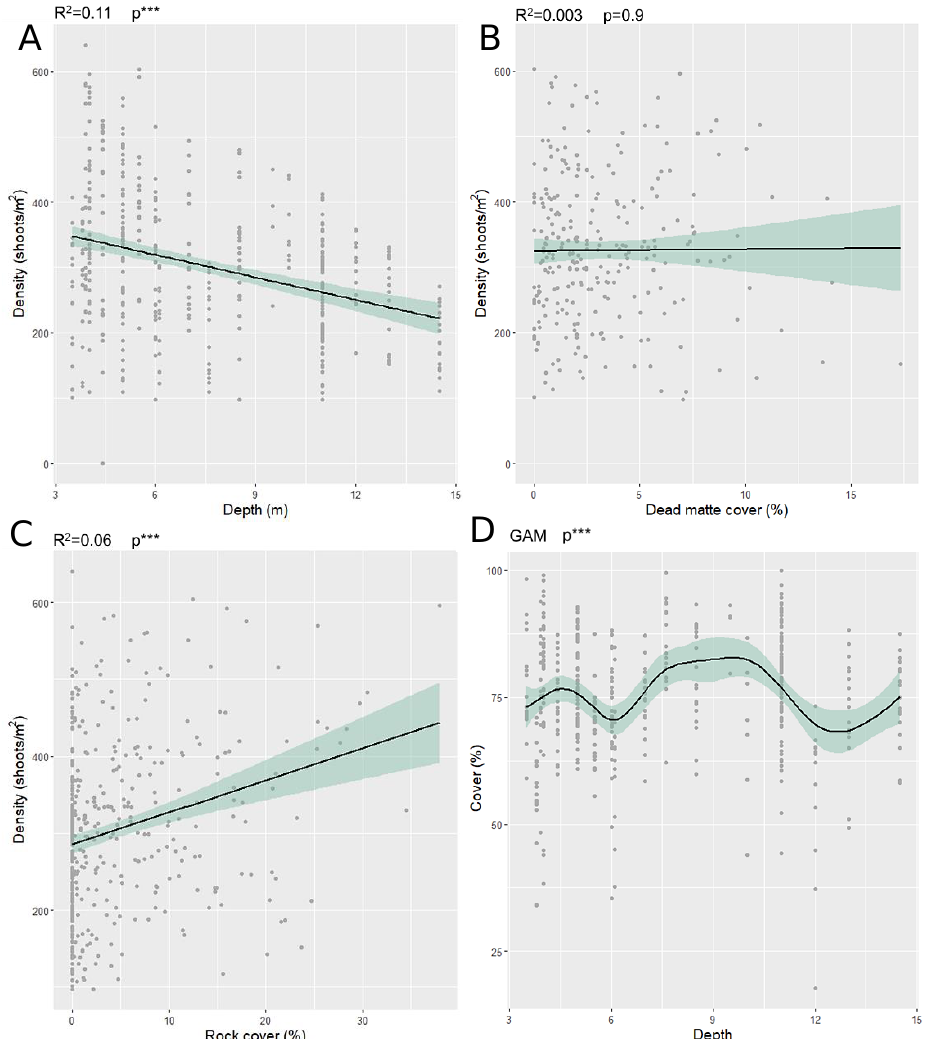
Figure 3. Linear regression between shoot density and ( A ) depth, ( B ) dead matte cover, and ( C ) rock cover; ( D ) GAM model showing the change of P. oceanica cover with depth. Fitted lines from generalized additive models are presented with 95% confidence intervals. Coefficient of determination (R 2 ) and needed transformations are shown. Results of linear regression: *** = p < 0.005.